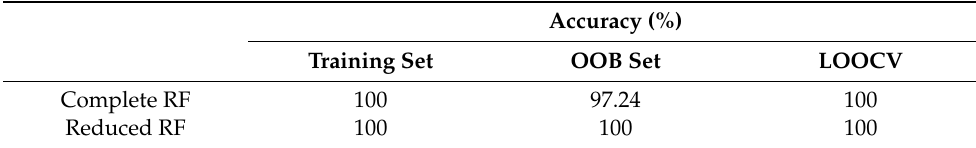
Table 1. Accuracy of both RF models for the different validations.